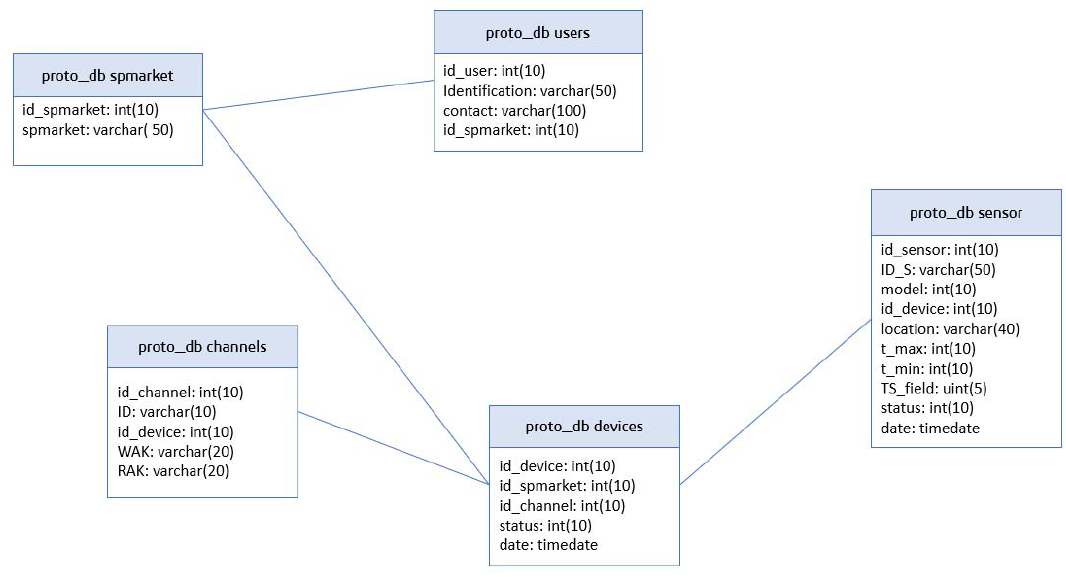
Figure 10. Database structure.